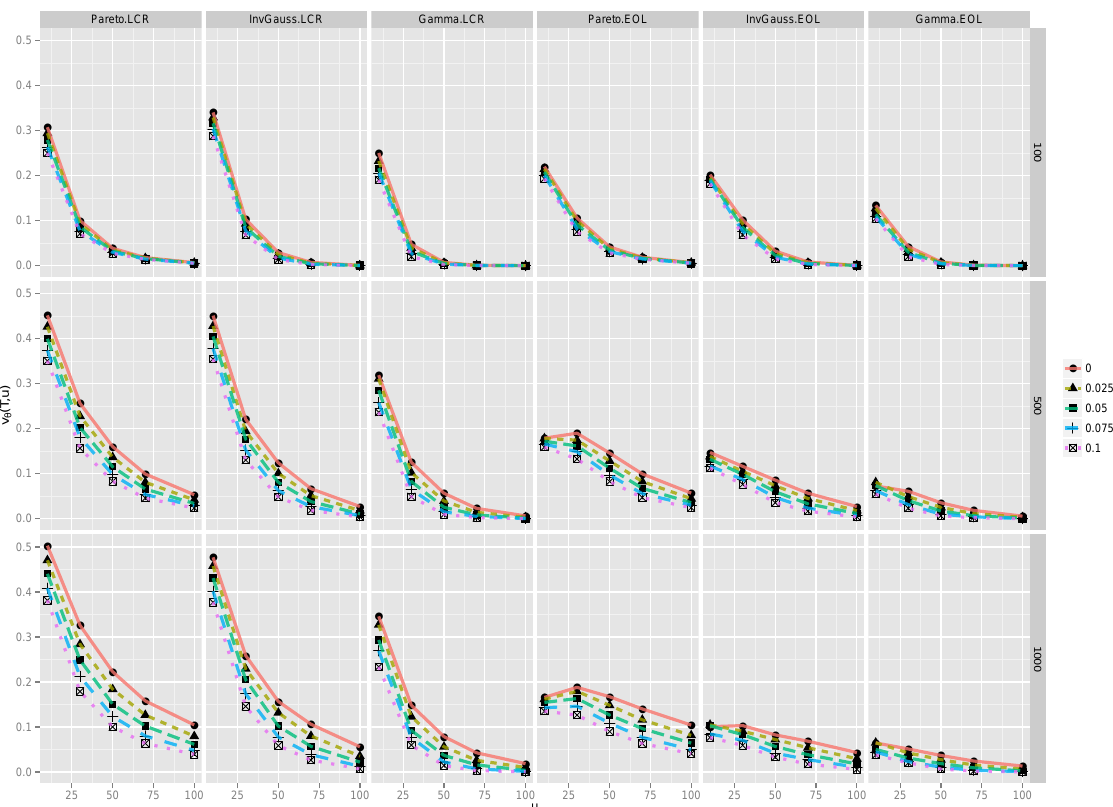
Figure 8. v θ ( T , u ) (from (37)) is the proportion of the dividend available to pay for reinsurance without reduing the value of the firm. For LCR and EOL reinsurance policies, Pareto, Inverse Gaussian and Gamma claim distributions, initial reserve levels u = 10, 30, 50, 70, 100, time value of money ρ = 0.0005, and safety loadings θ = 0, 0.025, 0.05, 0.075, 0.1. Top panel: T = 100; Middle panel: T = 500; Bottom panel: T = 1000. Retention level L for EOL reinsurance is the solution to (17). For T = 100, L ( T ) = 5.64, 6.89, 4.49; for T = 500, L ( T ) = 12.62, 11.27, 6.10; for T = 1000, L ( T ) = 17.84, 13.39, 6.79 for Pareto, Inverse Guassian and Gamma distributions respectively. Simulations are done with N = 10,000 sample